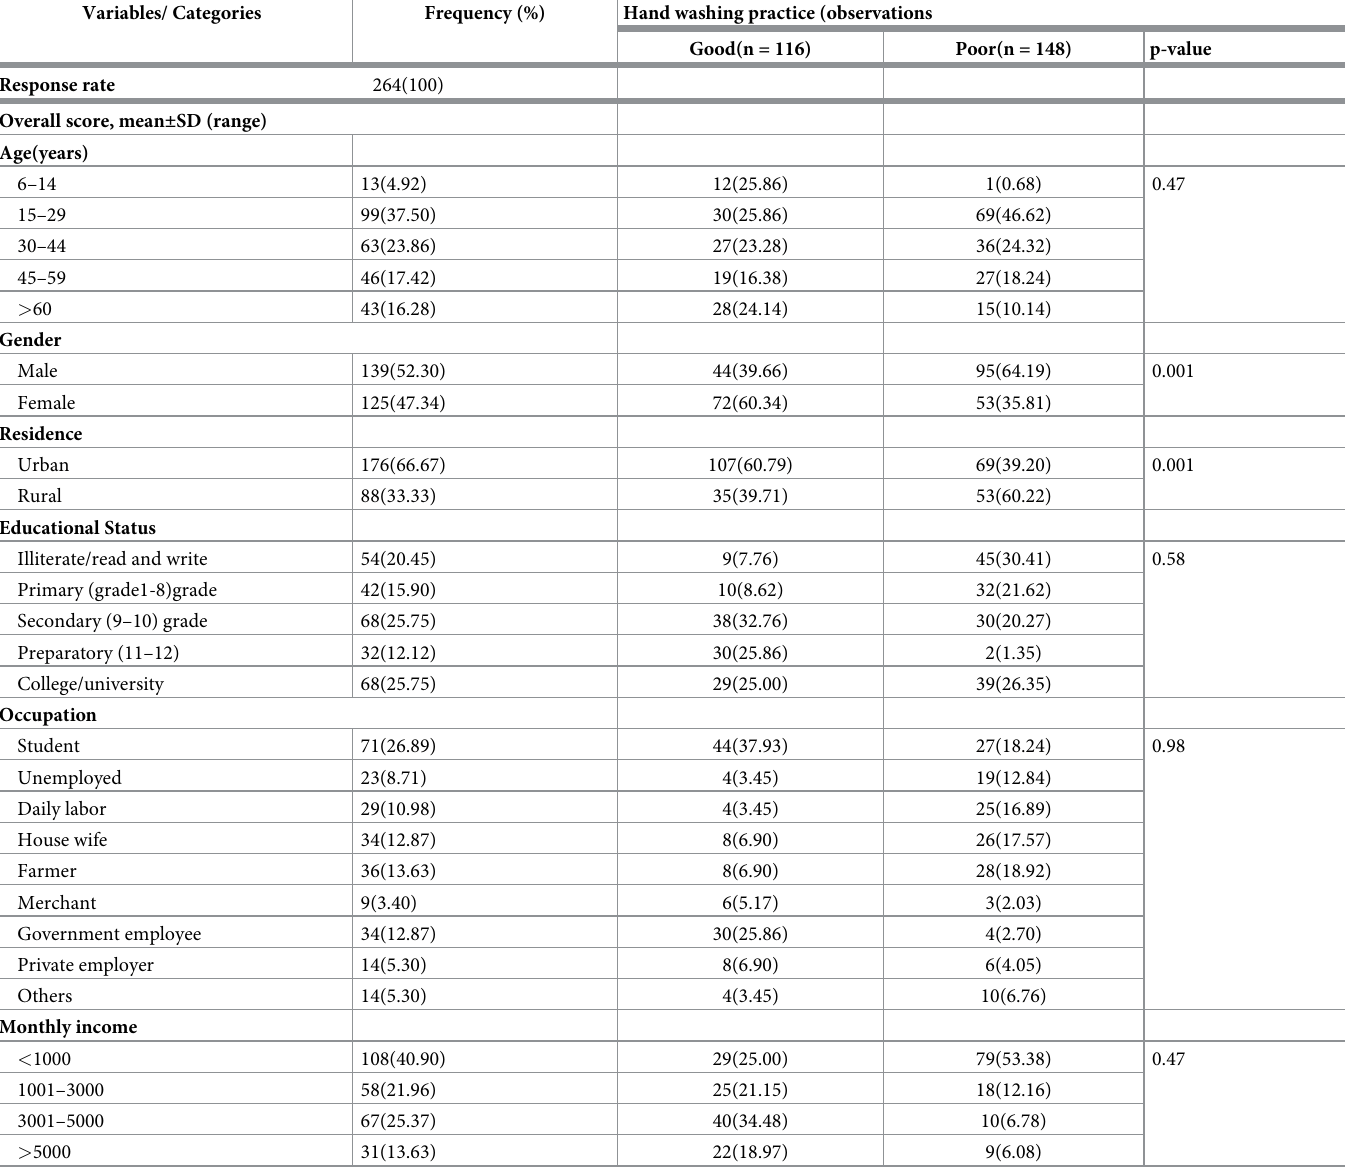
Table 1. Socio-demographic characteristics of study participants stratified by the two group based on the compliance to hand hygiene practice during COVID 19 pandemic in Arba Minch general hospital, southern Ethiopia between June to September 2021 (n = 264). Variables/